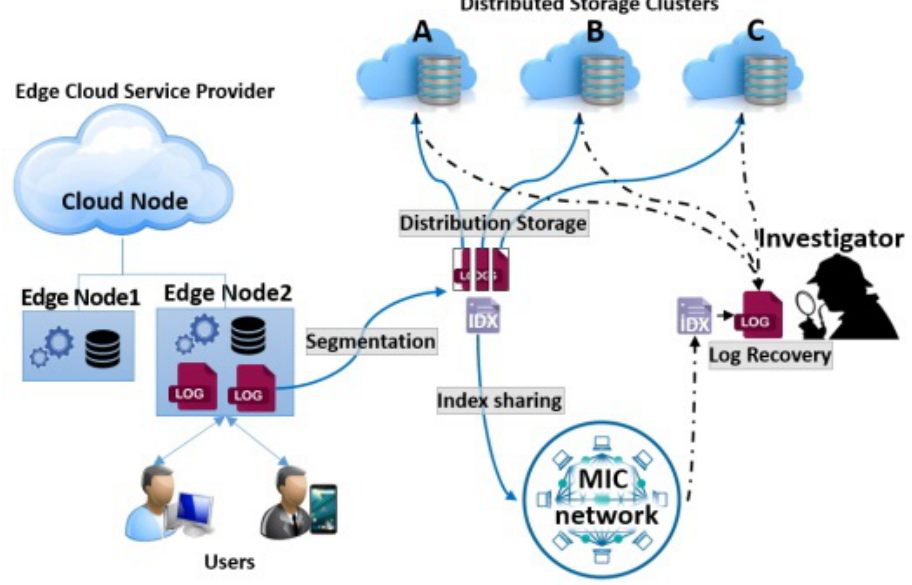
Figure 2. Digital forensic investigation for Edge/Cloud systems. Reproduced from